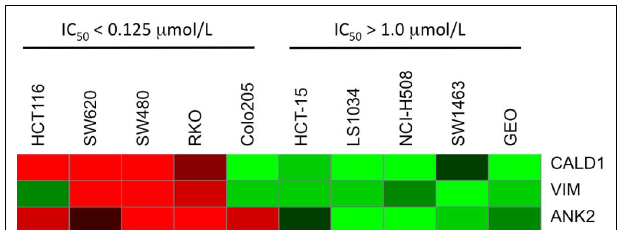
measured by densitometry and the mean ( n = 2 spots) is presented in the graphs as a fold increase over control. (C) HCT116 and GEO were treated with 1 μ mol/L of PF-3758309 for 8 h and levels of B-catenin were assessed.